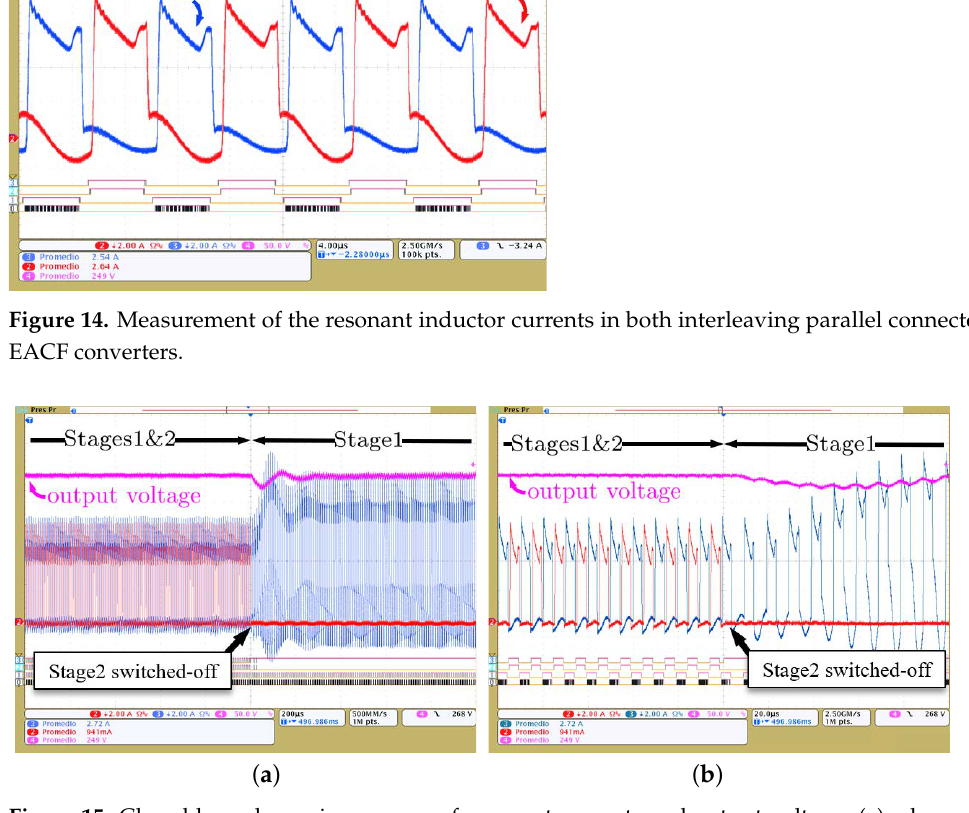
Figure 15. Closed loop dynamic response of resonant currents and output voltage: ( a ) when one stage was switched off; ( b ) expanded curves.